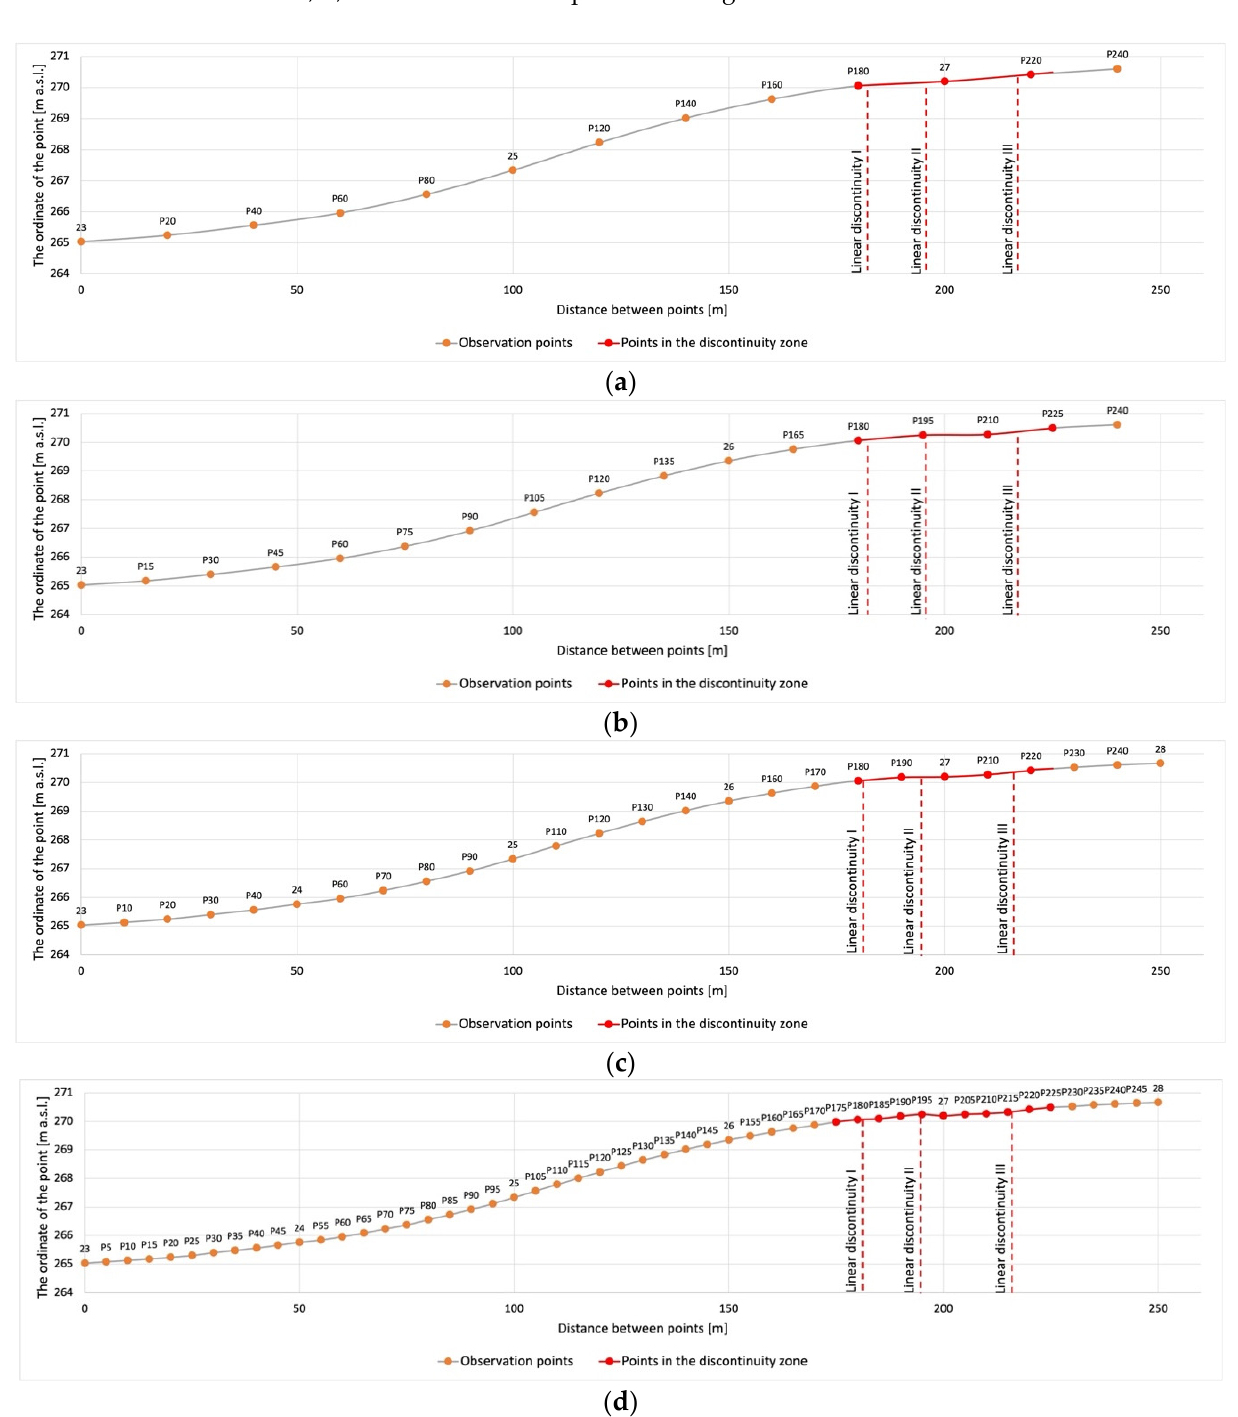
Figure 17. Graphs of lowering measurement points located at a distance of ( a ) 20 m, ( b ) 15 m, ( c ) 10 m and ( d ) 5 m.